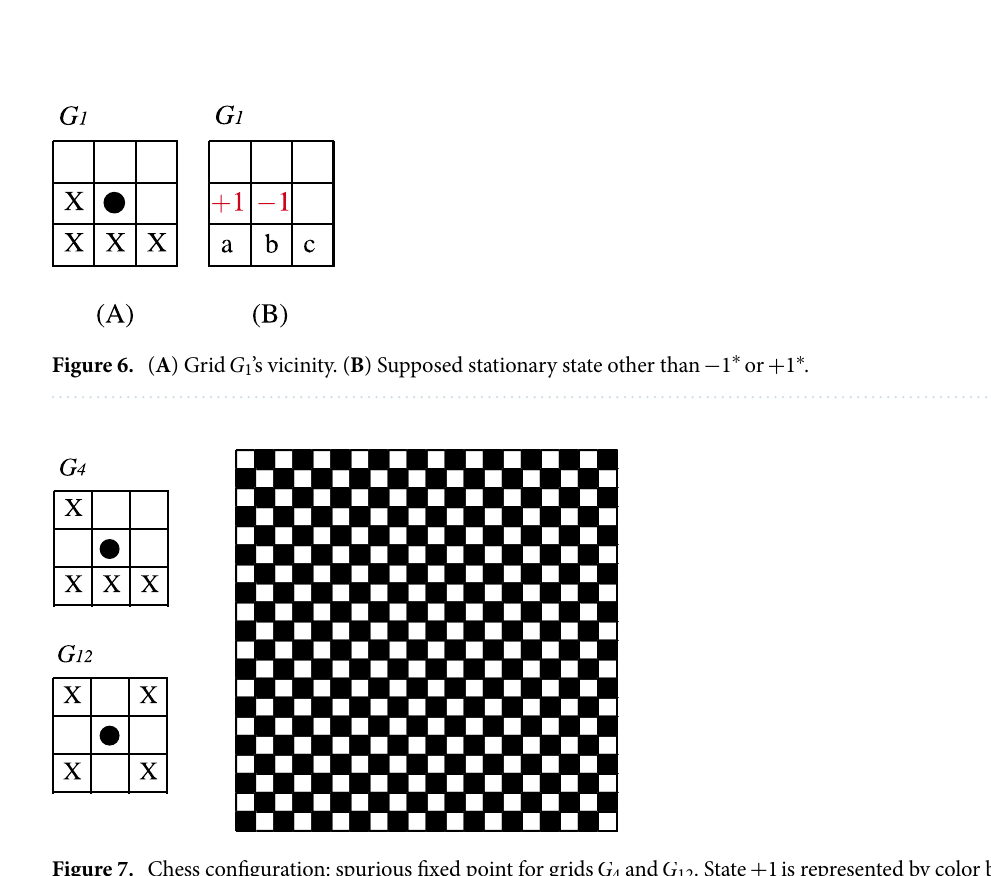
Figure 7. Chess configuration: spurious fixed point for grids G 4 and G 12 . State + 1 is represented by color black and − 1 is represented by color